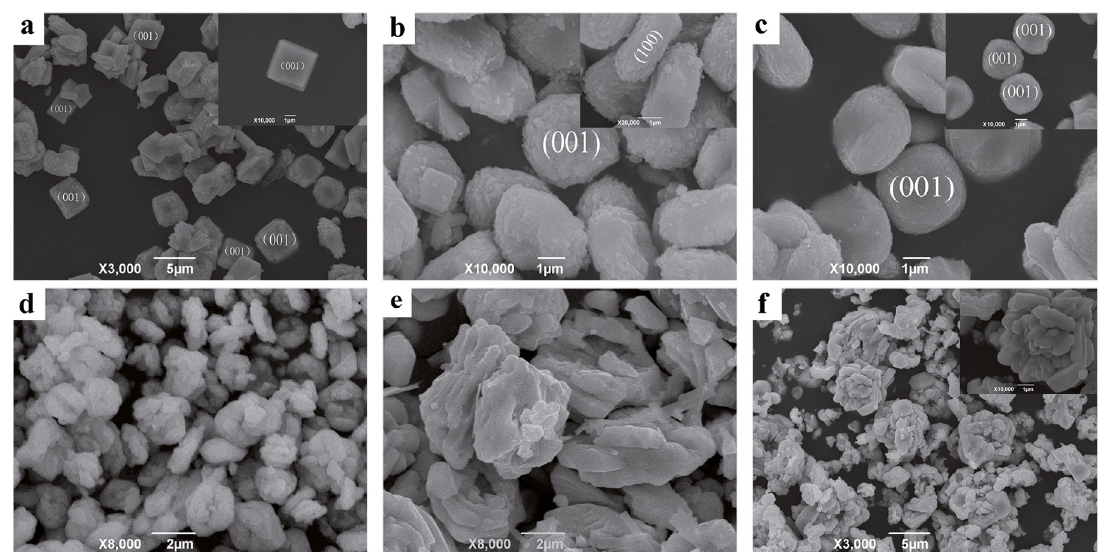
products obtained at pH=5 and 180 o C for different hydrothermal times at 180 o C. (a) 1 h, (b) 4 h, (c) Figure 3: SEM images of CdMoO 4 8 h, (d) 16 h, (e) 24 h, and (f) 48